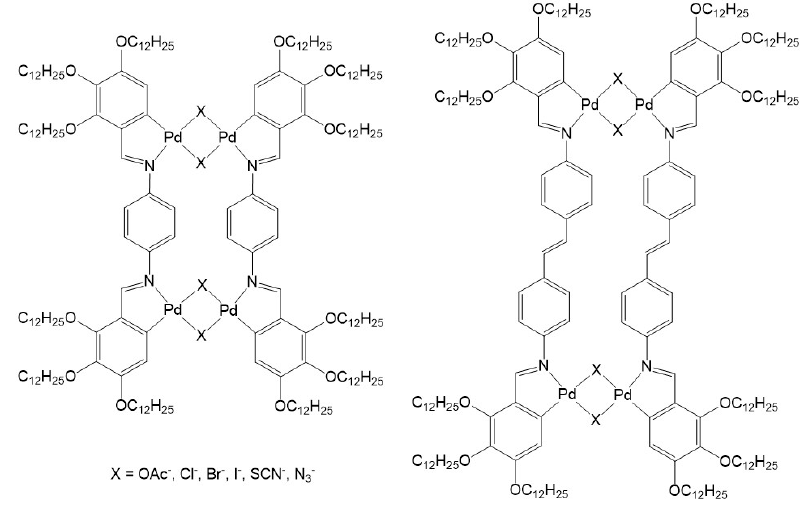
Figure 1. Early supramolecular coordination complexes showing liquid-crystalline properties [20].